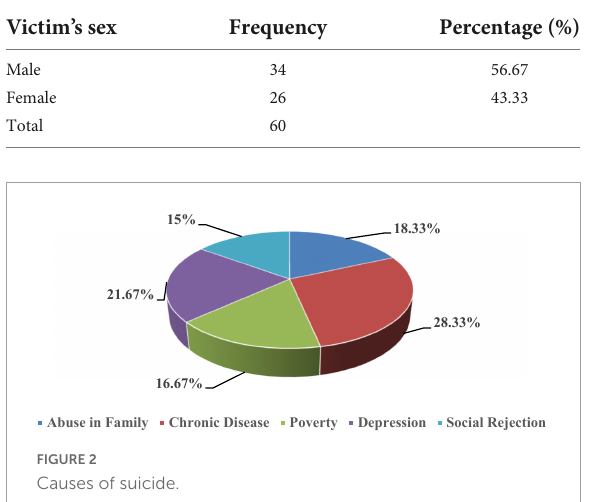
TABLE 2 Victim’s sex.